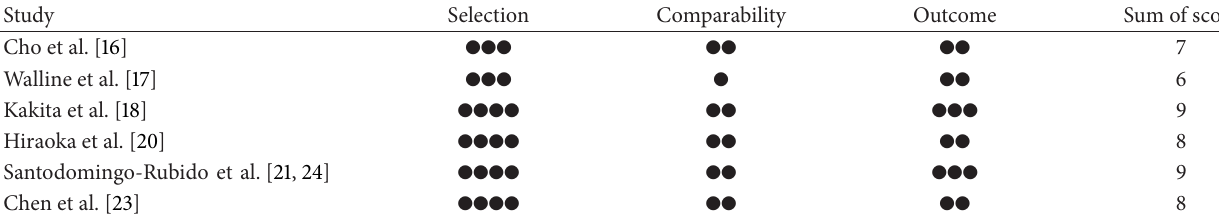
Table 4: NOS for cohort studies.